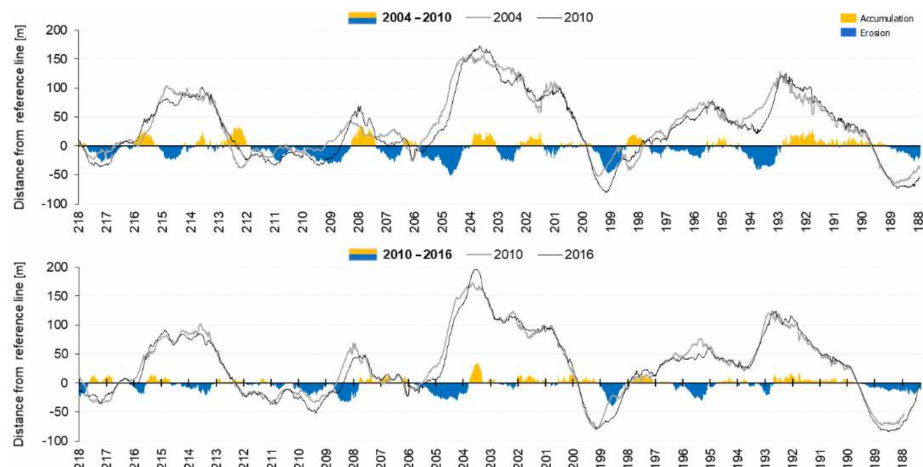
Figure 8. Graphs of the changes in the accumulated and eroded areas in two 6 year time intervals (2004–2010 and 2010–2016) on the studied part of the coast (188–218 km according to MOK).